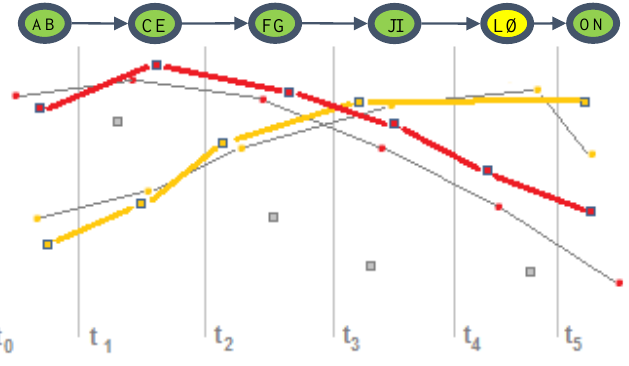
Figure 5. The resulting Viterbi path (blue) for the given example.